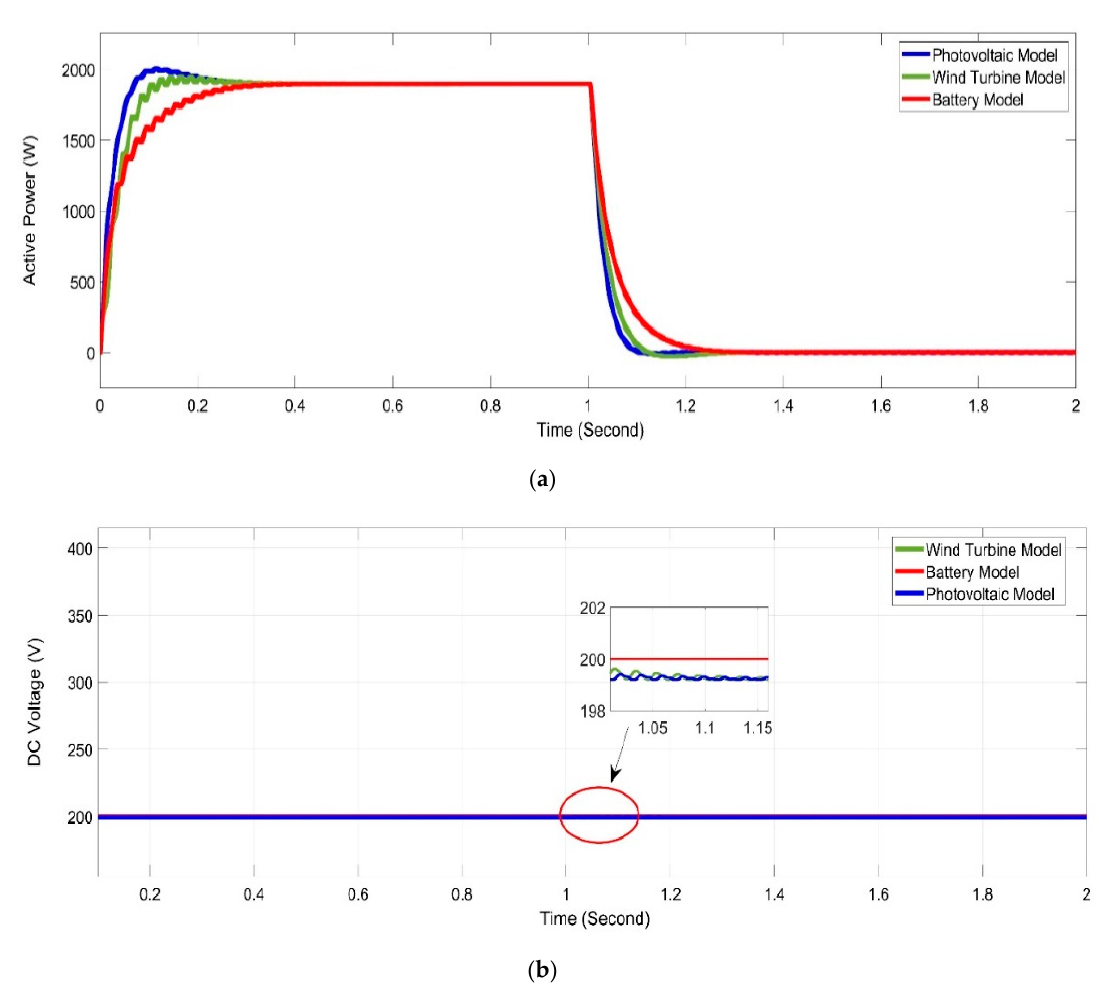
Figure 12. Simulation of identical distribution lines are used, ( a ) inverters power response, ( b ) DC link voltage response under loads change.